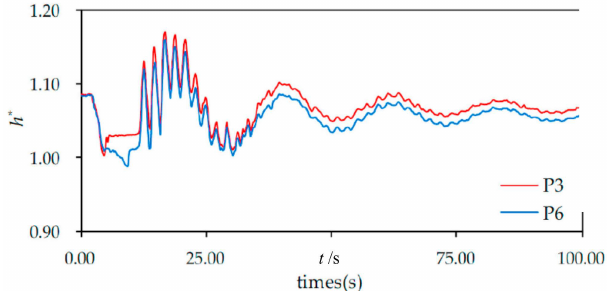
Figure13. Changeprocessesofpressureoscillationatdi ff erentmonitoringpointsinatailracetunnel[31].